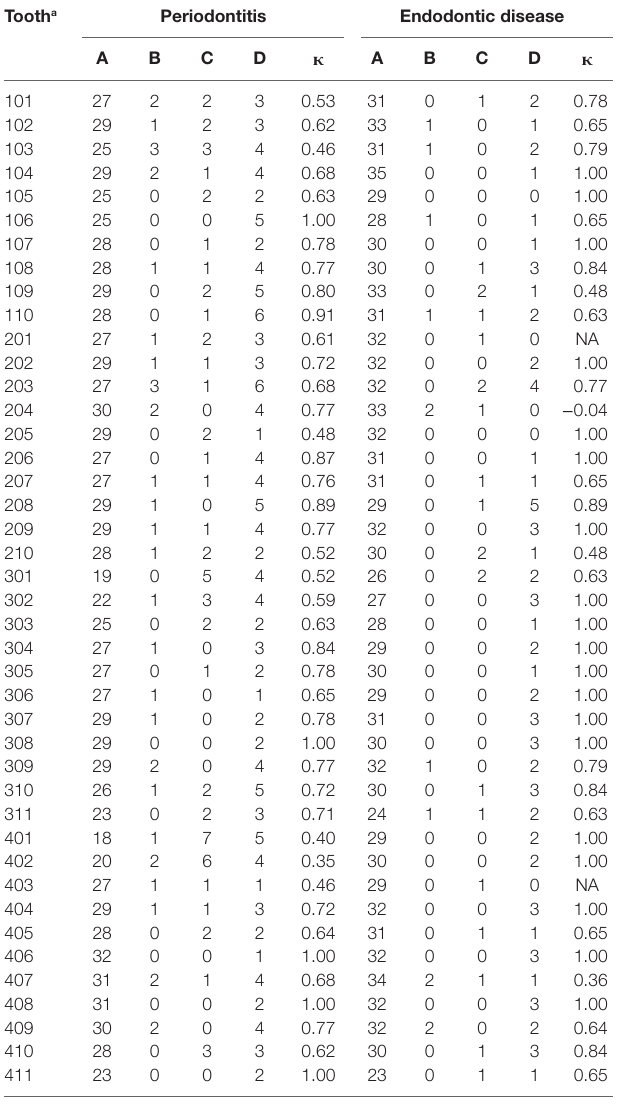
TaBle 4 | Observer comparison for cT. Tooth